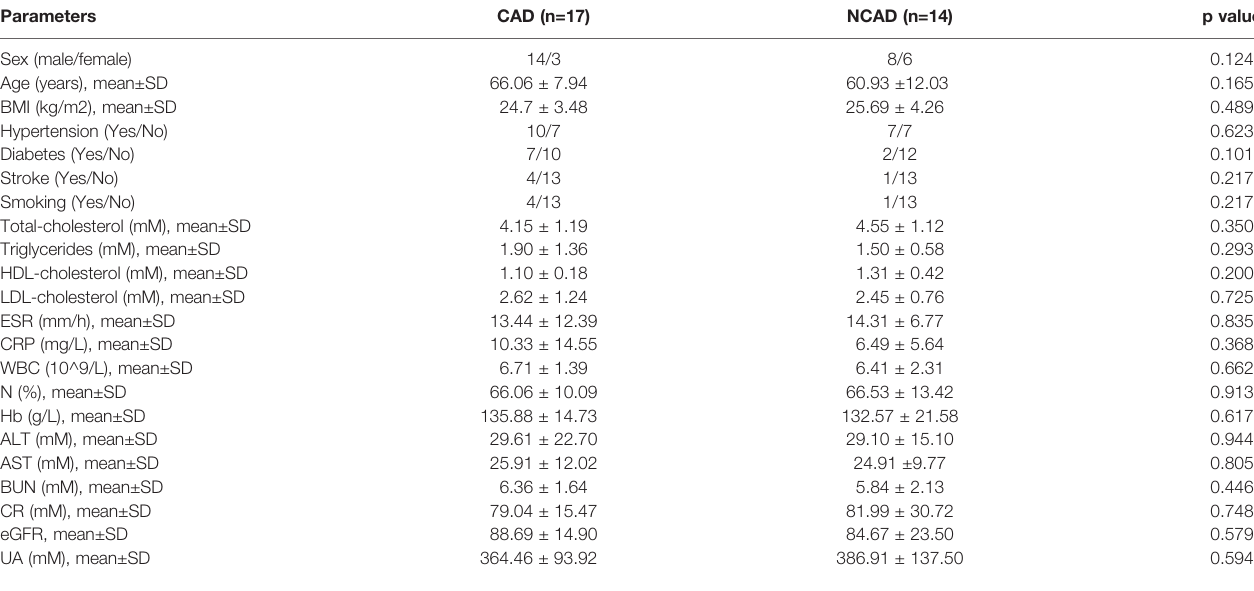
TABLE 2 | Clinical characteristics of the subjects.